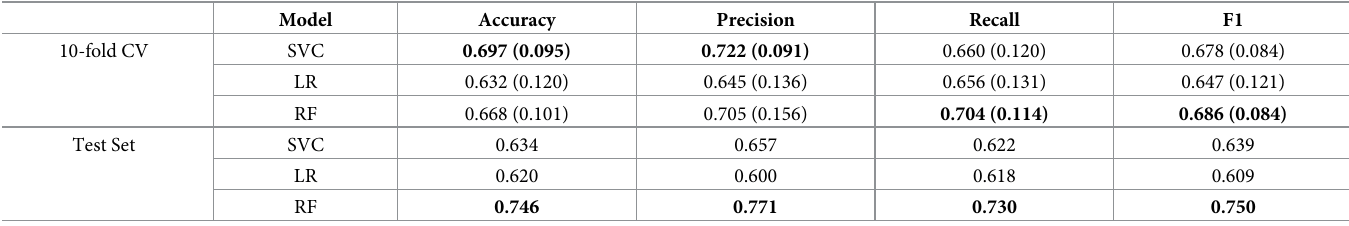
Table 1. Model performance obtained by the 10-fold CV (top) where the mean (standard deviation) are reported, and evaluated on test set (bottom) for AD classifi- cation using acoustic features. Bold indicates the best overall performance for the